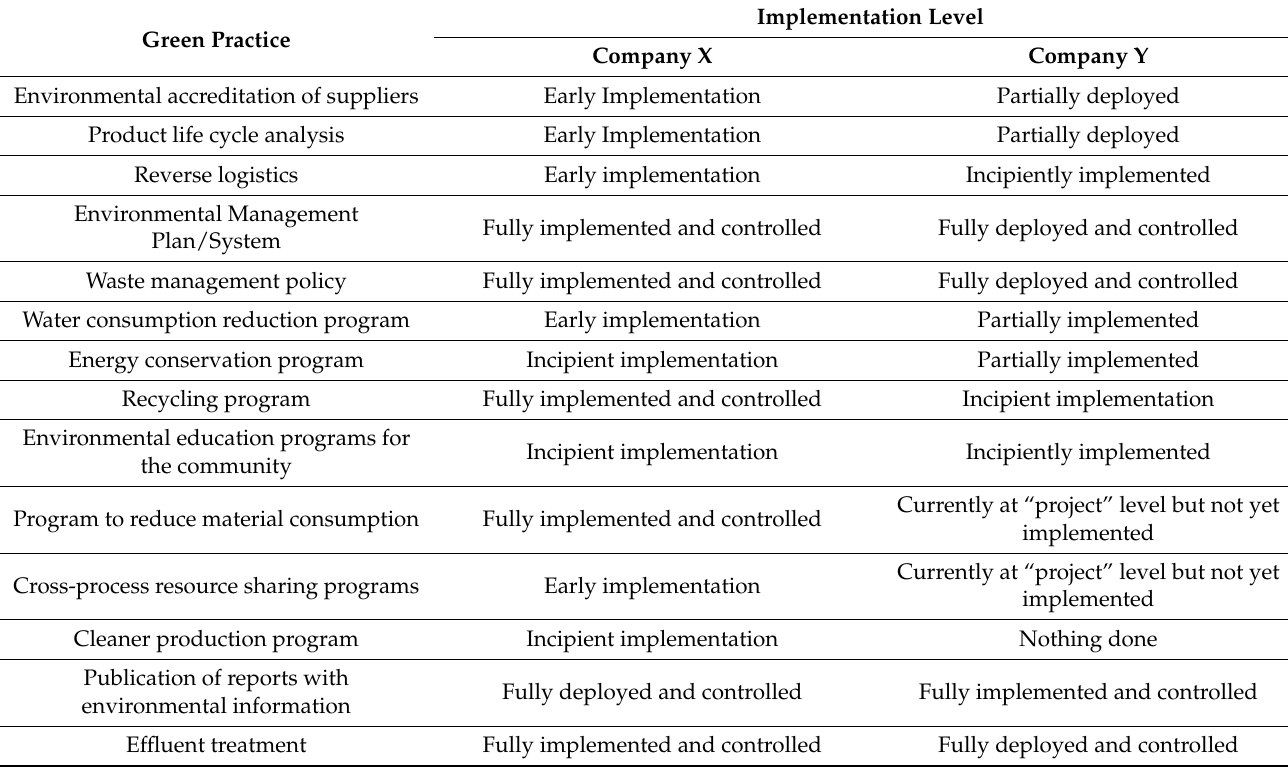
Table 3. The companies’ green